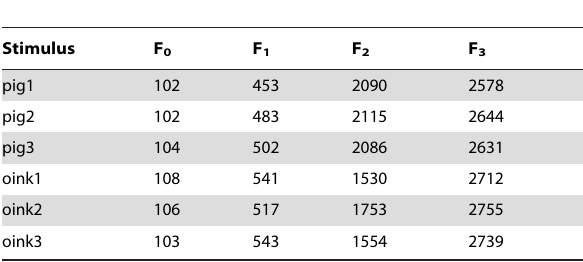
Table 2. Pitch and mean formant frequencies of the main speech stimuli (in